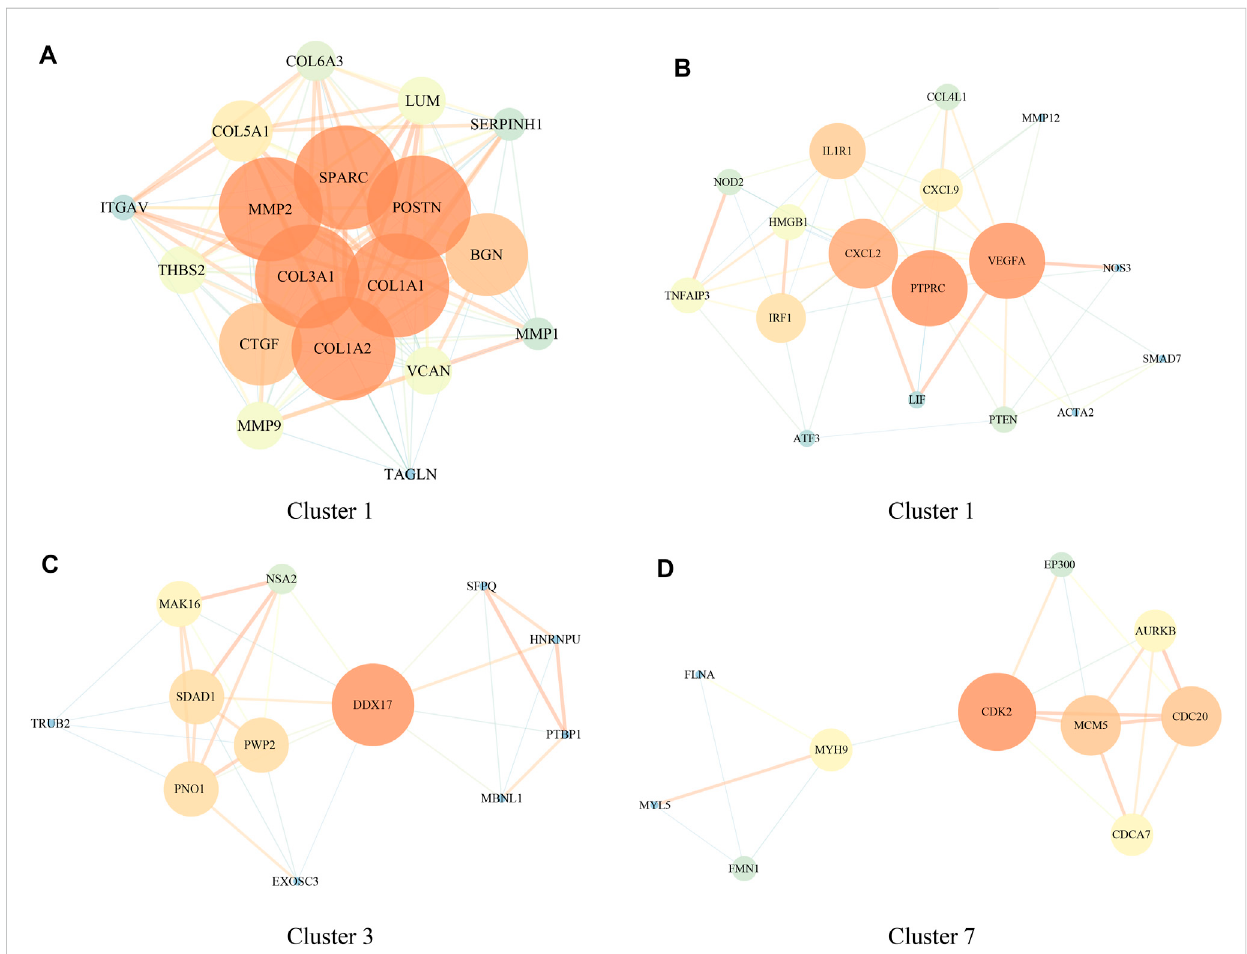
263 genes showing signi fi cantly high frequency mutations were screened between different RiskScore groups (Supplementary Table S1). The mutational signatures of the top 20 genes are shown in Supplementary Figure S5A. Distributions of the number of segments, fraction altered, tumor mutation burden, and homologous recombination defects among subtypes were compared; however, these mutational signatures did not differ signi fi cantly across the different RiskScore groups (Supplementary Figure